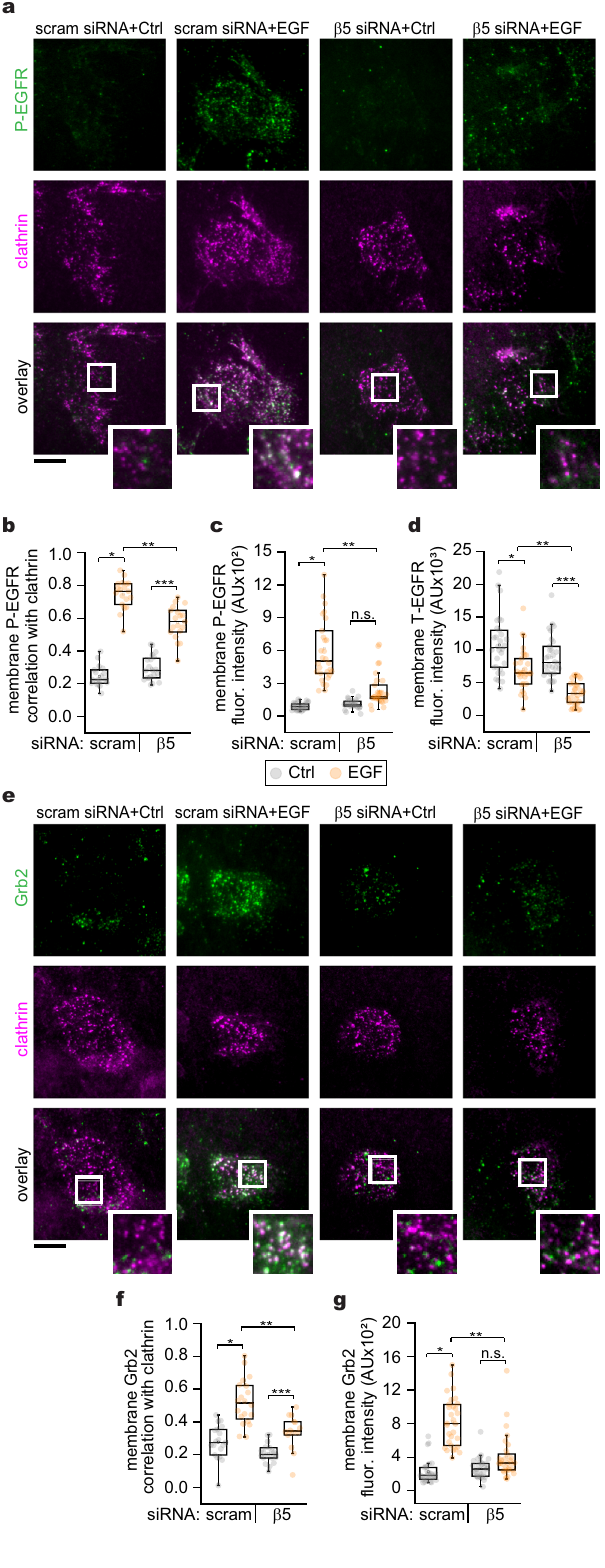
oil immersion objective (100x/1.49 NA, SR HR Apo TIRF, Nikon), and a 50/50 mirror combining the epi lamp and TIRF laser illumination (Nikon 21014-UF2). Epi-illumination for IRM was performed with a mercury lamp illuminator (Intensilight C-HGFI, Nikon) fi ltered with a 515 long-pass fi lter. A dichroic below the objective (Omega 490-600DBDR) was used to re fl ect a 488 nm TIRF illumi- nation laser and the IRM epi-illumination sequentially into the objective. Images